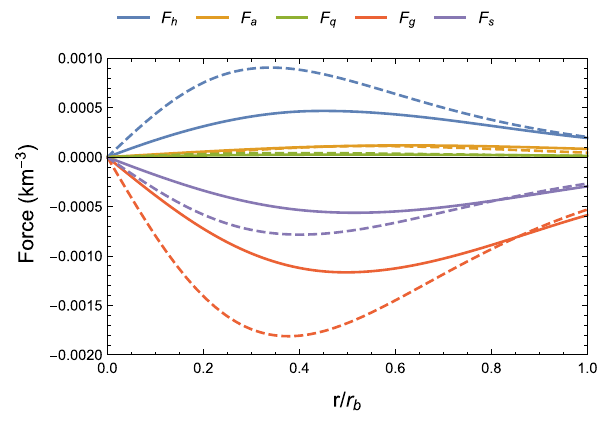
Fig. 4 Force profiles at f = 0 . 5 for K = − 2 (solid) and K = − 20 (dashed)